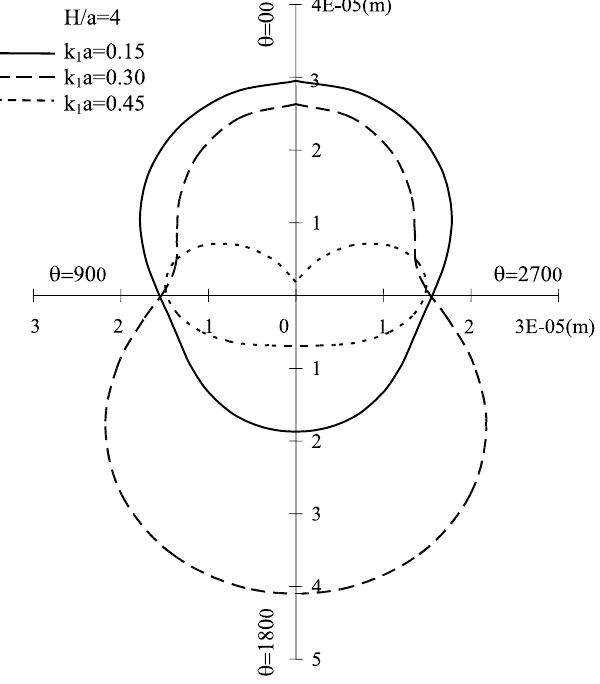
Fig. 2. Variation of the radial displacement ( u r ) with θ at r = a for various values of wave number k 1 a